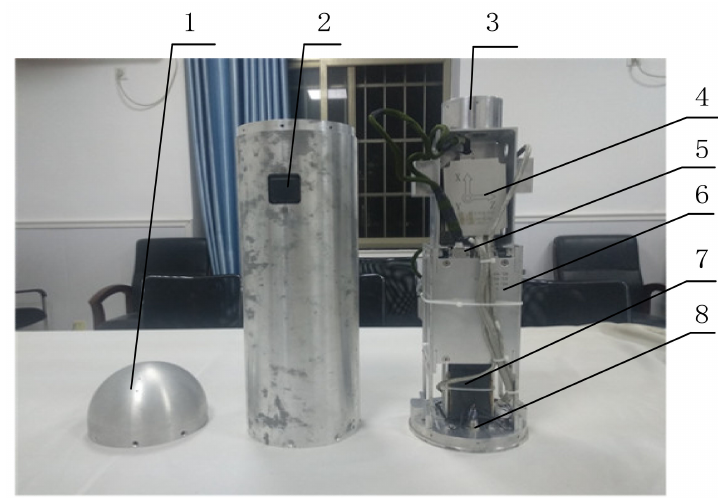
Figure 11. Physical picture of flush air data sensing module. 1-Pressure measuring hole, 2-Satellite antenna, 3-Onboard computer, 4-Integrated navigation, 5-Electrical interface, 6-Data recorder, 7- Battery pack, 8-System switch.